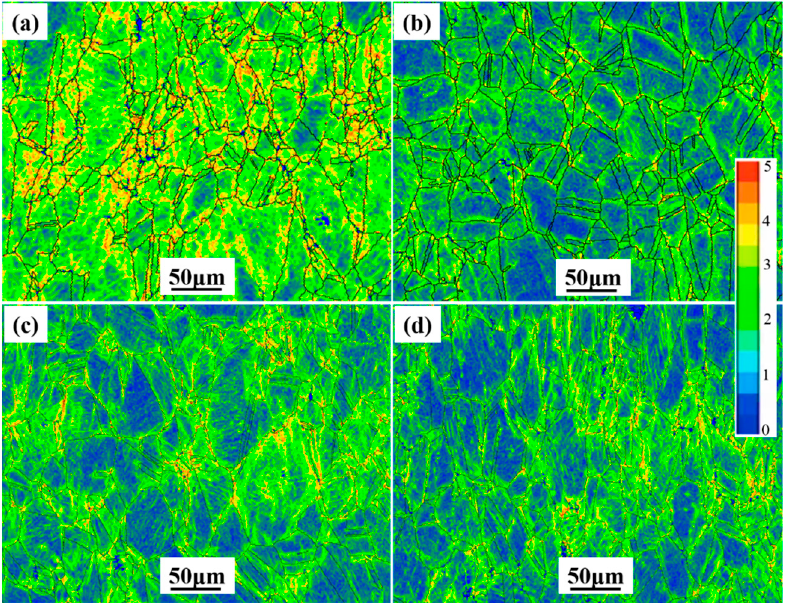
Figure 8. Kernel average misorientation (KAM) of the alloy measured for fractured tensile specimen surface. ( a ) Specimen A; ( b ) specimen B; ( c ) specimen C; ( d ) specimen D.